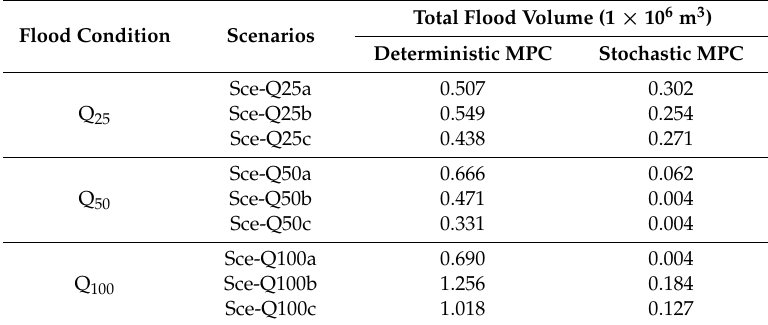
Table 4. Flood volume assessment of deterministic and stochastic closed-loop MPC for different inflow conditions with forecast horizon of 48 h.